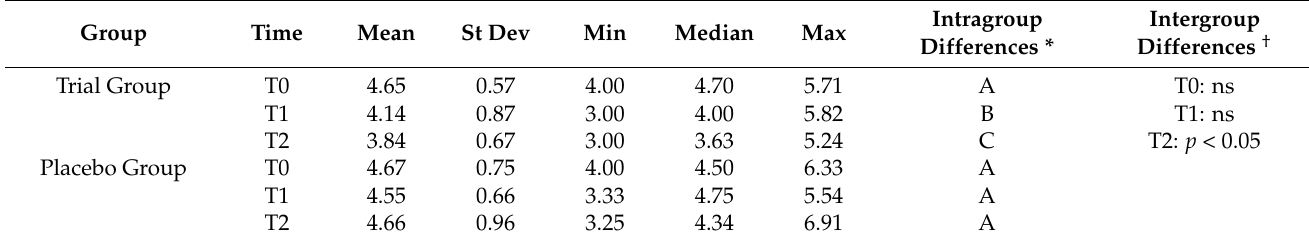
Table 2. Descriptive statistics of Probing Pocket Depth measurements (PPD).